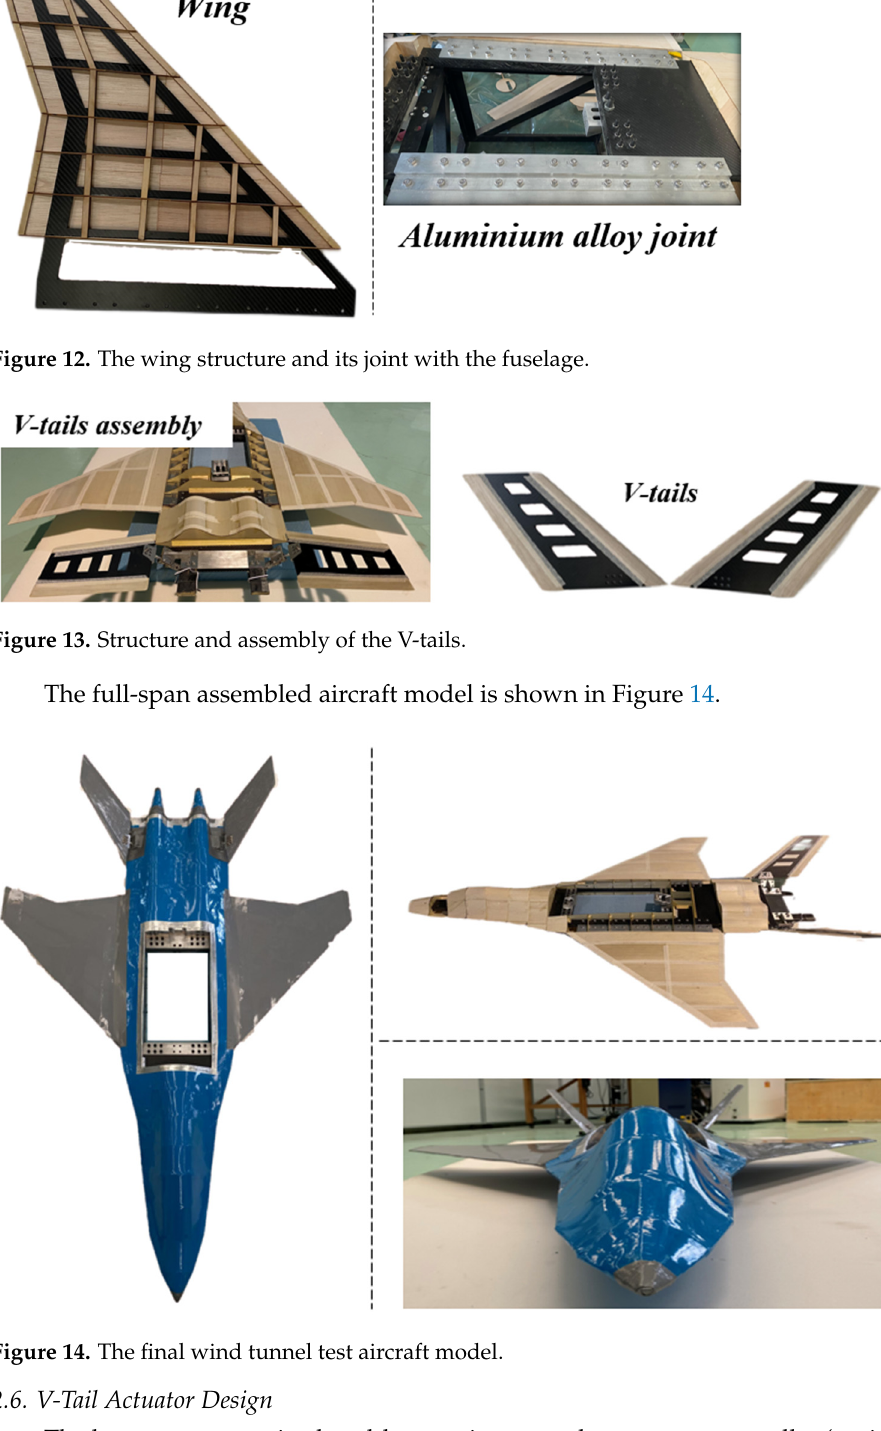
Figure 11. Structure design and assembly of the fuselage core board. The materials of the core board: ① carbon fiber; ② balsa wood; and ③ carbon fiber.